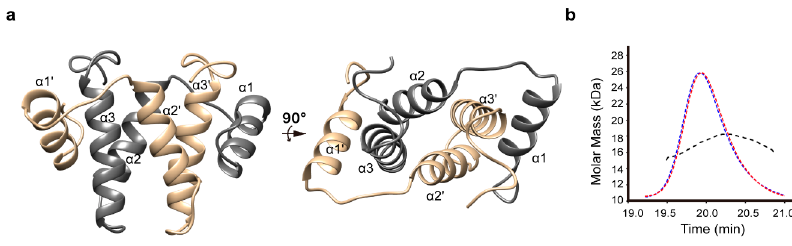
Figure 1. Structural description of SF173. ( a ) Ribbon presentation of the SF173 crystal structure. Individual polypeptide chains are shown in different colors (gold and gray). ( b ) Size exclusion chromatography (SEC) multi-angle light scattering (MALS) analysis of SF173. Elution profile was detected by MALS (red) and refractive index (RI; blue) and the calculated molar mass of SF173 is fitted by black dotted lines.